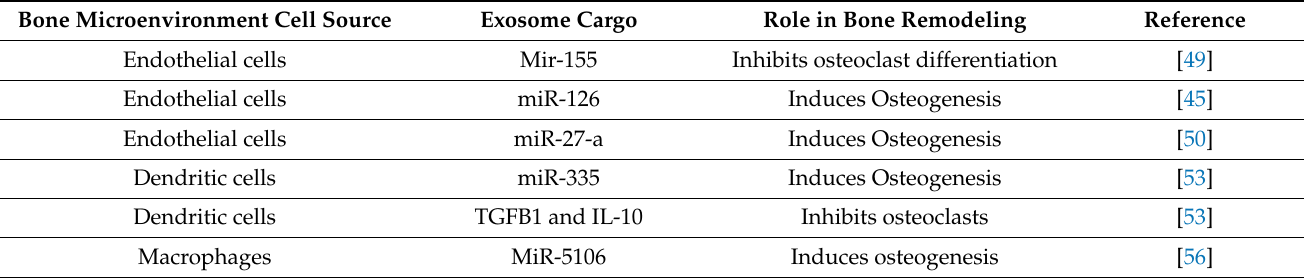
Table 2. Exosome cargo derived from bone microenvironment cells and their role in bone remodeling. Bone Microenvironment Cell